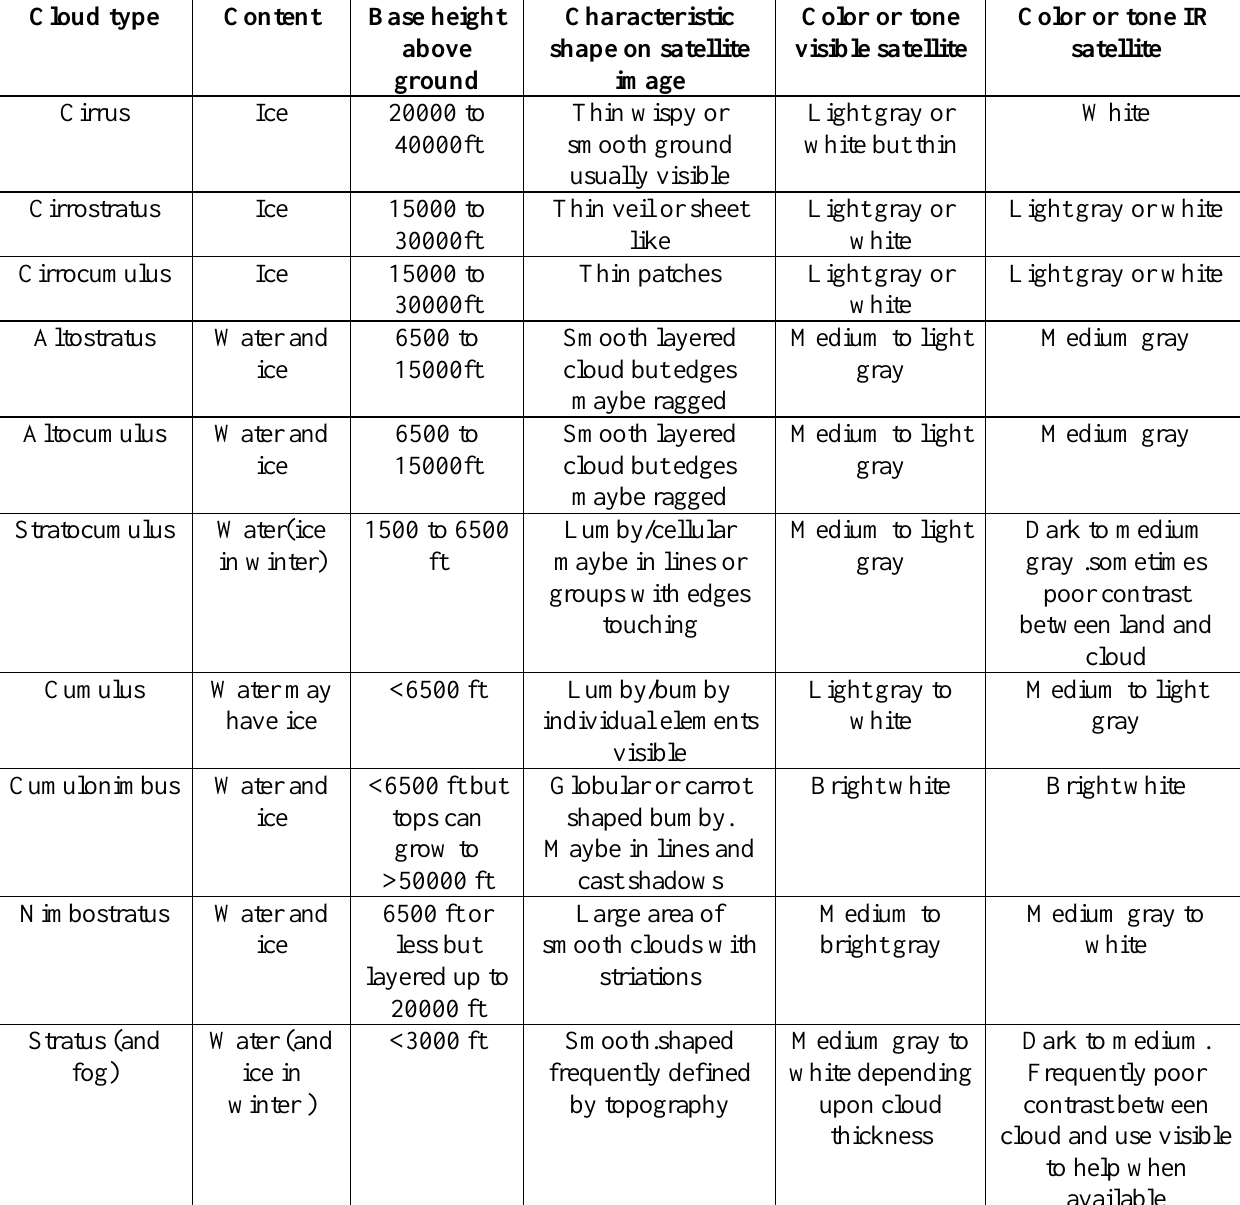
Table 10: The brightness of the clouds in visible and infrared satellite